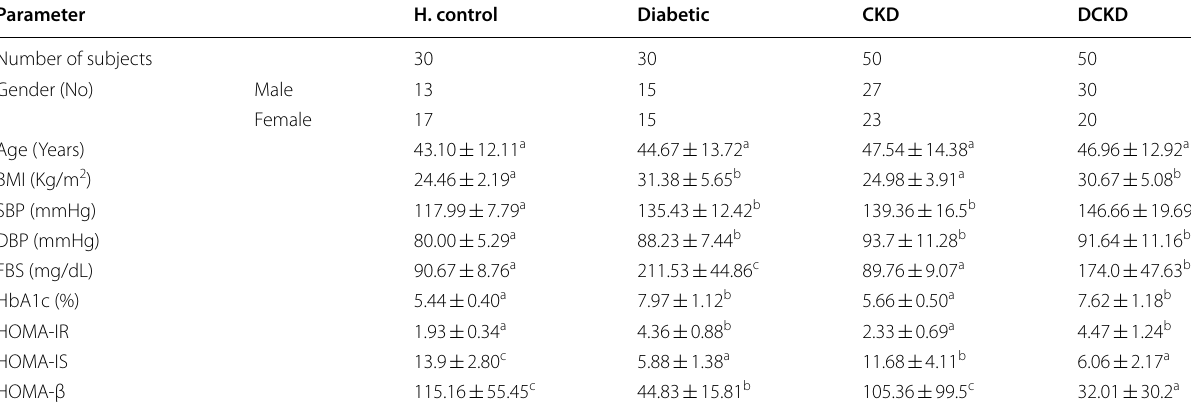
Data are expressed as means SD. Values that share the same superscript symbol(s) are not significantly different. H: healthy, CKD: chronic kidney disease, DCKD: ± diabetic chronic kidney disease. SBP: systolic blood pressure, DBP: diastolic blood pressure, BMI: body mass index, HbA1c: glycosylated hemoglobin, FBS: fasting blood sugar, HOMA-IR: homeostasis model assessment for insulin resistance, HOMA-IS: homeostasis model assessment for insulin sensitivity, HOMA-β: homeostasis model assessment for beta-cell function